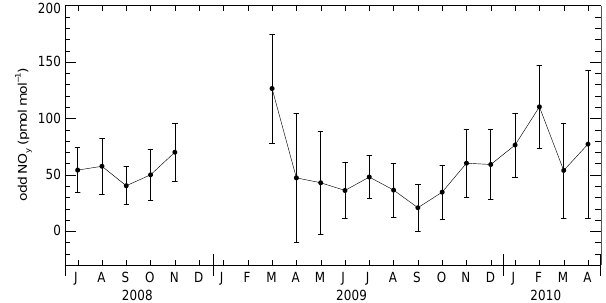
Figure 2. Monthly mean levels of NO y and PAN + NO x at Sum- mit calculated from individual 30min averages for 2008–2010 at Summit. Error bars represent uncertainty in the measurements re- sulting from measurement accuracy, calibration uncertainty, and ar- tifact corrections as discussed in Sects. 2.2.1, 2.2.2, and the Sup- plement. Uncertainties in PAN + NO x were determined from the propagation of errors. Only coincident data are considered in this analysis.